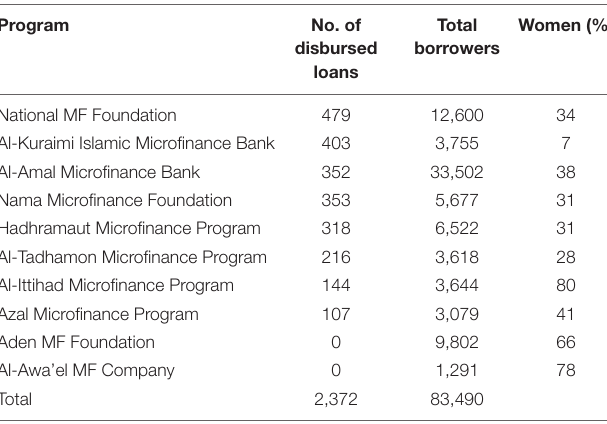
TABLE 2 | The status of women entrepreneurs supported by microfinance